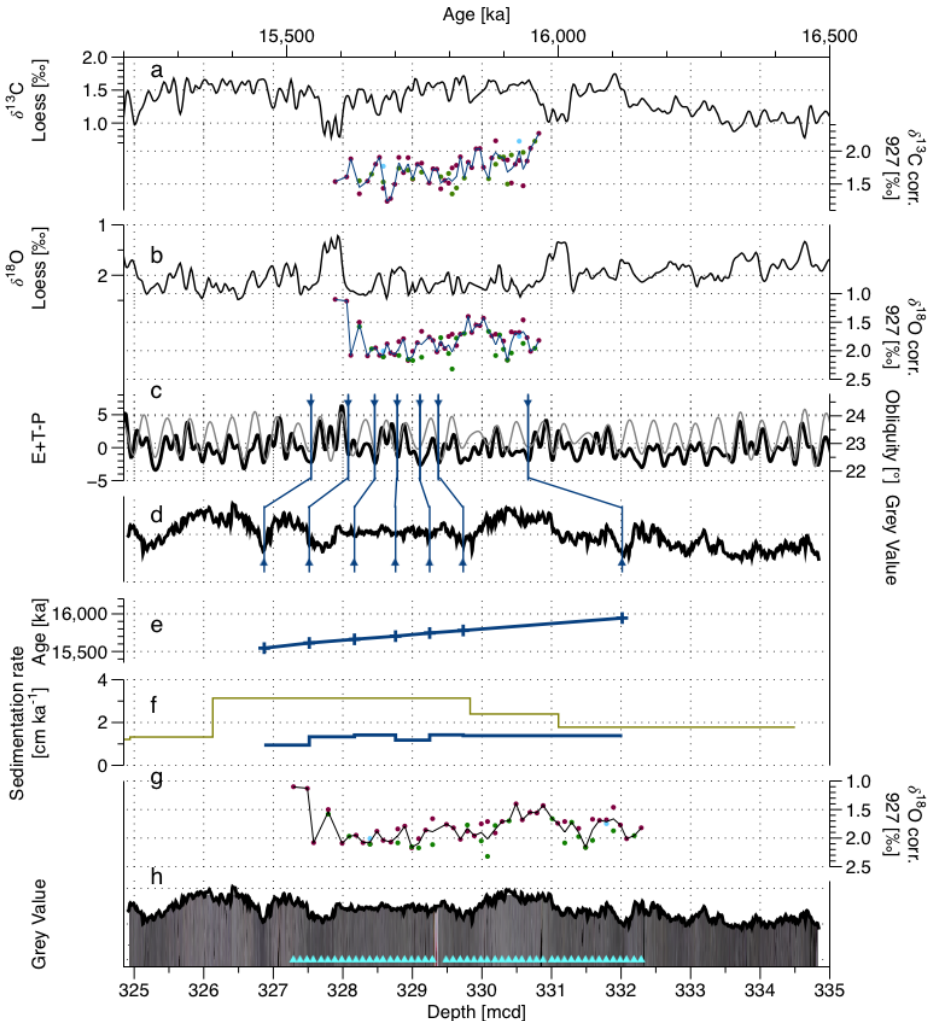
Figure 7. Depth–age correlation for the Mid-Miocene, core 154 927 A33H. (a) The δ 13 C loess smooth composite record (from sites U1337 and U1338, Westerhold et al., 2020) and corrected δ 13 C measured in Miocene samples from this study ( O.umbonatus in pink, C. mundulus in green, and C. wuellerstorfi in blue; the line corresponds to the average value). (b) The δ 18 O loess smoothed composite record (from sites U1337 and U1338, Westerhold et al., 2020) and corrected δ 18 O measured in Miocene samples from this study ( O.umbonatus in pink, C. mundulus in green, and C. wuellerstorfi in blue; the line corresponds to the average value). (c) The obliquity (grey) and E + T − P (black) records (Laskar et al., 2004). (d) The SSA of the grey value record extracted from the core image and corrected from the light bias. (e) The age–depth relationship and control points. (f) SR from the Shackleton et al. (1999) age model (green), from nannofossil events (Curry et al., 1995; Pälike et al., 2010; Wilkens et al., 2017) (dark blue) and from this study (blue). (g) The corrected δ 18 O measured on Miocene samples from this study against depth ( O.umbonatus in pink, C. mundulus in green and C. wuellerstorfi in blue; the line corresponds to the average value). (h) The core image (Wilkens et al., 2017), smoothed grey value record and position of the samples for this study in the core (light blue